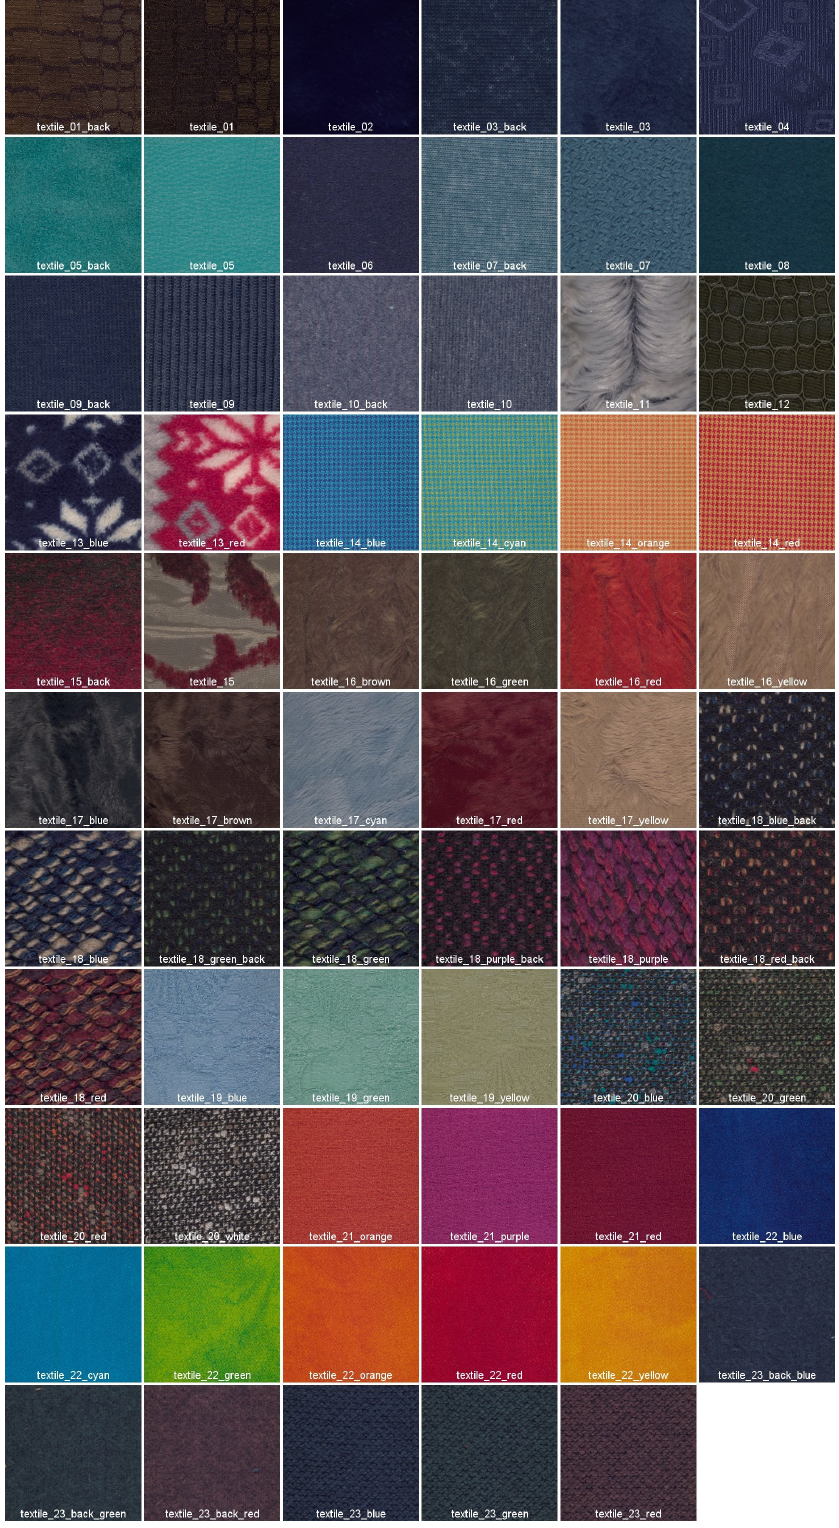
Figure 10. Reconstructed sRGB images from the textile category of the